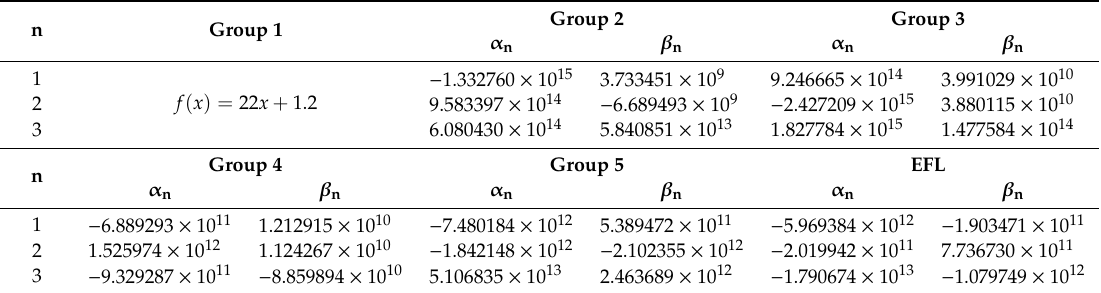
Figure 6. Movement of each lens group assuming linear movement of the first lens group. ( a ) Zoom locus of each lens group, ( b ) effective focal length (EFL) of the optical system, and ( c ) error for image plane. Table 4. Coefficients of rational function for each lens group calculated by the Padé approximation.